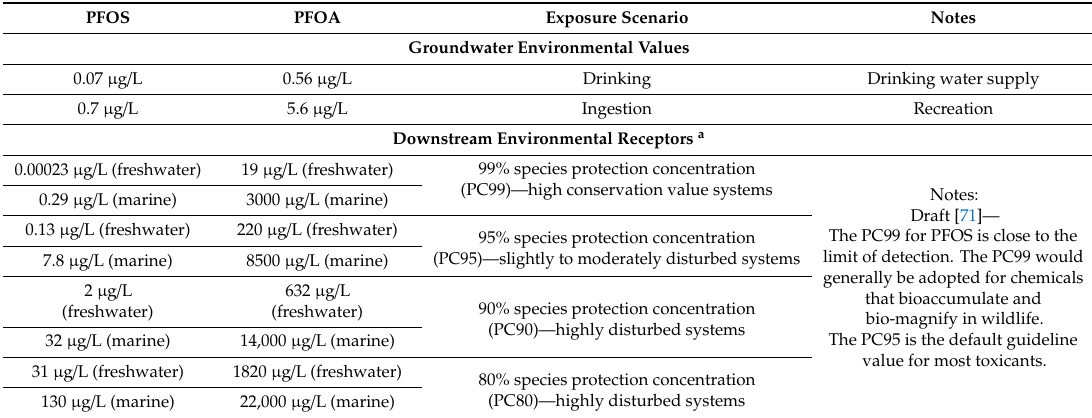
Table2. Australiandraftguidelinesrelevanttotypicalenvironmentalvaluesofaquifersanddownstream environmental receptor. Aquatic ecosystems: freshwater and marine water guideline values